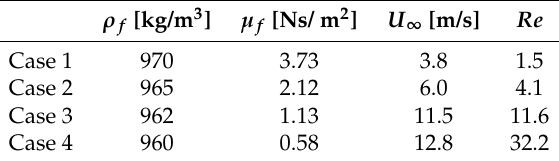
Table 1. Physical parameters used to simulate the sedimentation of a 3D sphere based on